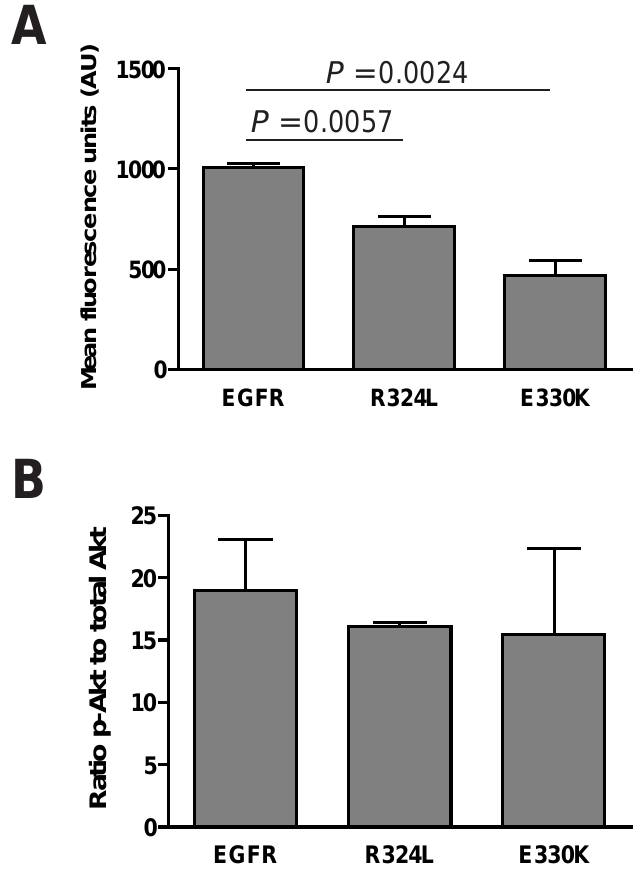
Figure 3. Activation of downstream pathways by mutant EGFR. Transgenic NR6 cells expressing wtEGFR, R324L and E330K were plated under serum free conditions and then lysed and tested by Bioplex for ( A ) pERK1/2 and ( B ) pAkt levels. Data is presented as mean fluorescent intensity ± S.E. or as a ratio of p-Akt to t-Akt ± S.E. of three independent replicates corrected for total Akt